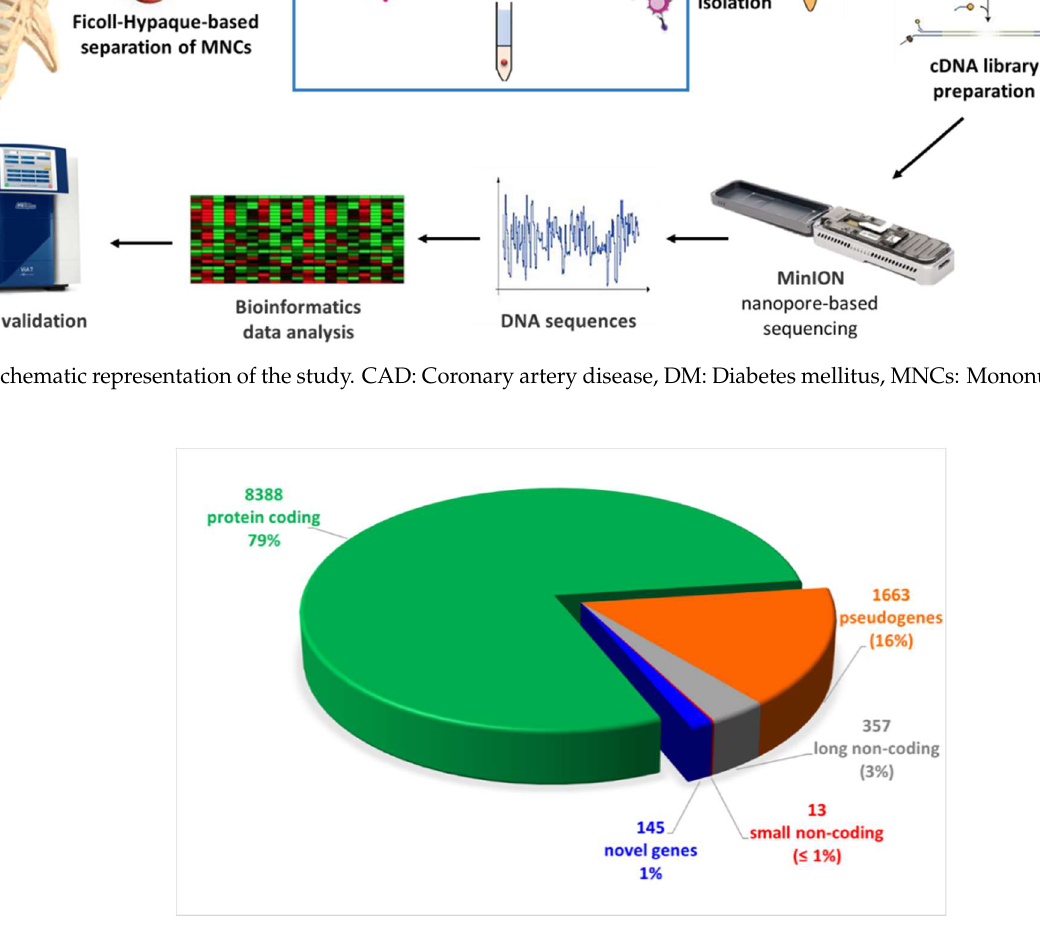
Figure 1. Schematic representation of the study. CAD: Coronary artery disease, DM: Diabetes mellitus, MNCs: Mononuclear cells.